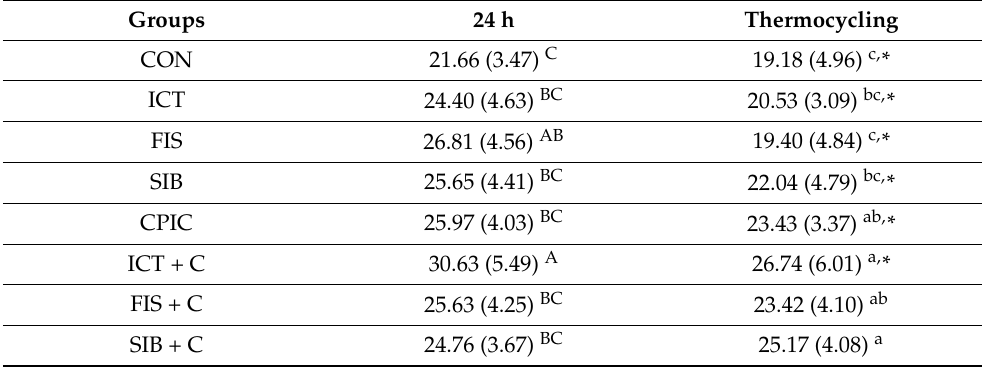
Table 4. Mean (SD) microtensile bond strength values in MPa of the experimental groups. Groups